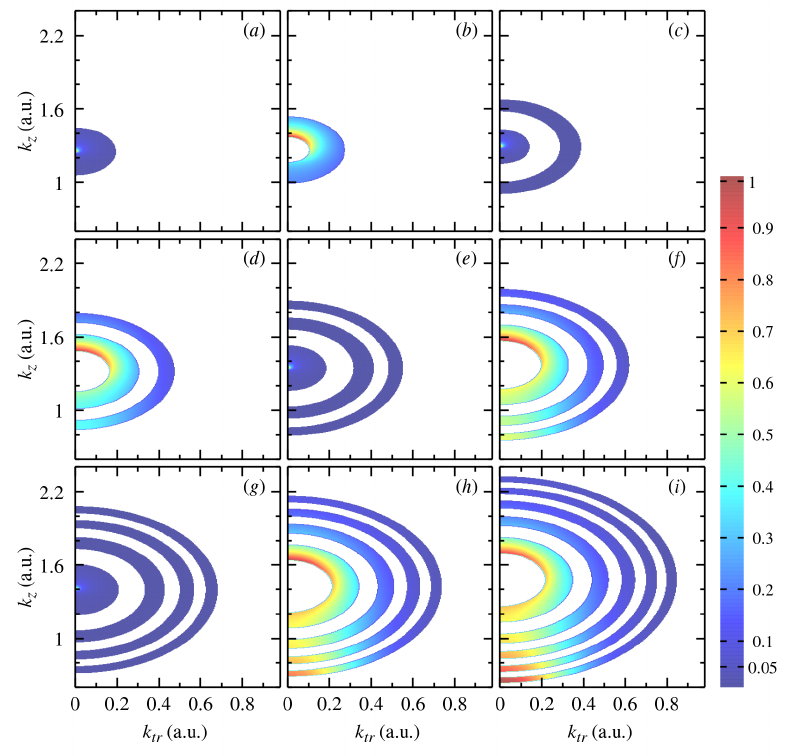
Figure 3. Spectra of electrons emitted from He atoms ( P i a = 50 a.u., v a = P i a / M a ≈ 7 × 10 − 3 a.u. → 0, ε i = − 0.9 a.u.) passed through a diffraction grating ( a = b = d /2 = 0.1 mm, N 0 = 5) in collisions with protons. D = 200 mm, P R , z = q x = q y = 0. The collision velocity v = f v 0 , where v 0 = and f = 0.93 ( a ), 0.94 ( b ), 0.96 ( c ), 0.98 ( d ), 1 ( e ), 1.02 ( f ), 1.04 ( g ), 1.06 ( h ), and 1.1 ( i ). The spectra are given in relative units with their intensities ranging from 0 to 1. The blank regions correspond to zero cross-section